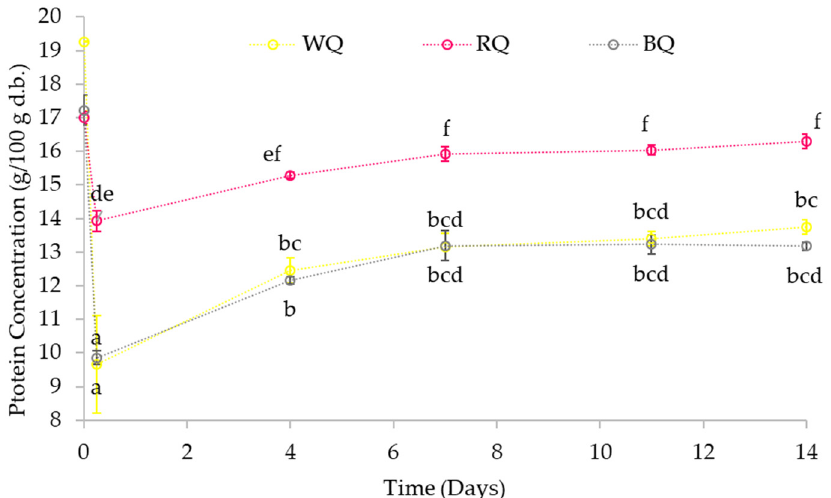
Figure 1. Protein content variation for white (WQ), red (RQ), and black (BQ) quinoa, during soaking (0.25 days), germination (4 and 7 days at 20 °C and 100% RH), and refrigerated storage (11 and 14 days at 4 °C and 75% RH). Error bars indicate standard deviation ( n = 3). Results with different letters are significantly different at p ≤ 0.05.